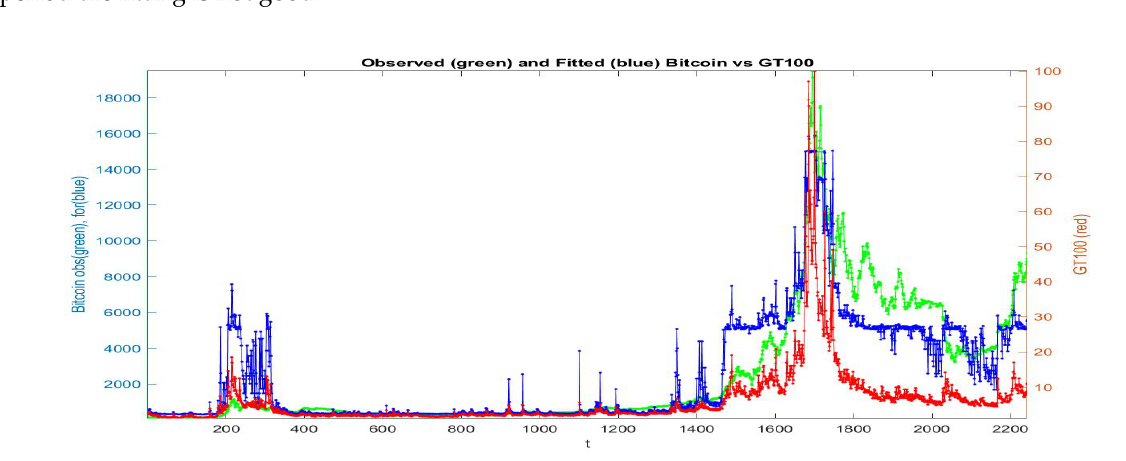
Figure 7. The fitted BitCoin time series (blue color) is obtained from L 2 -norm iF-transform function applied to the data-set ( GT 100 t , BitCoin t ) ; the observed BitCoin t values are green and the observed GT 100 t values are